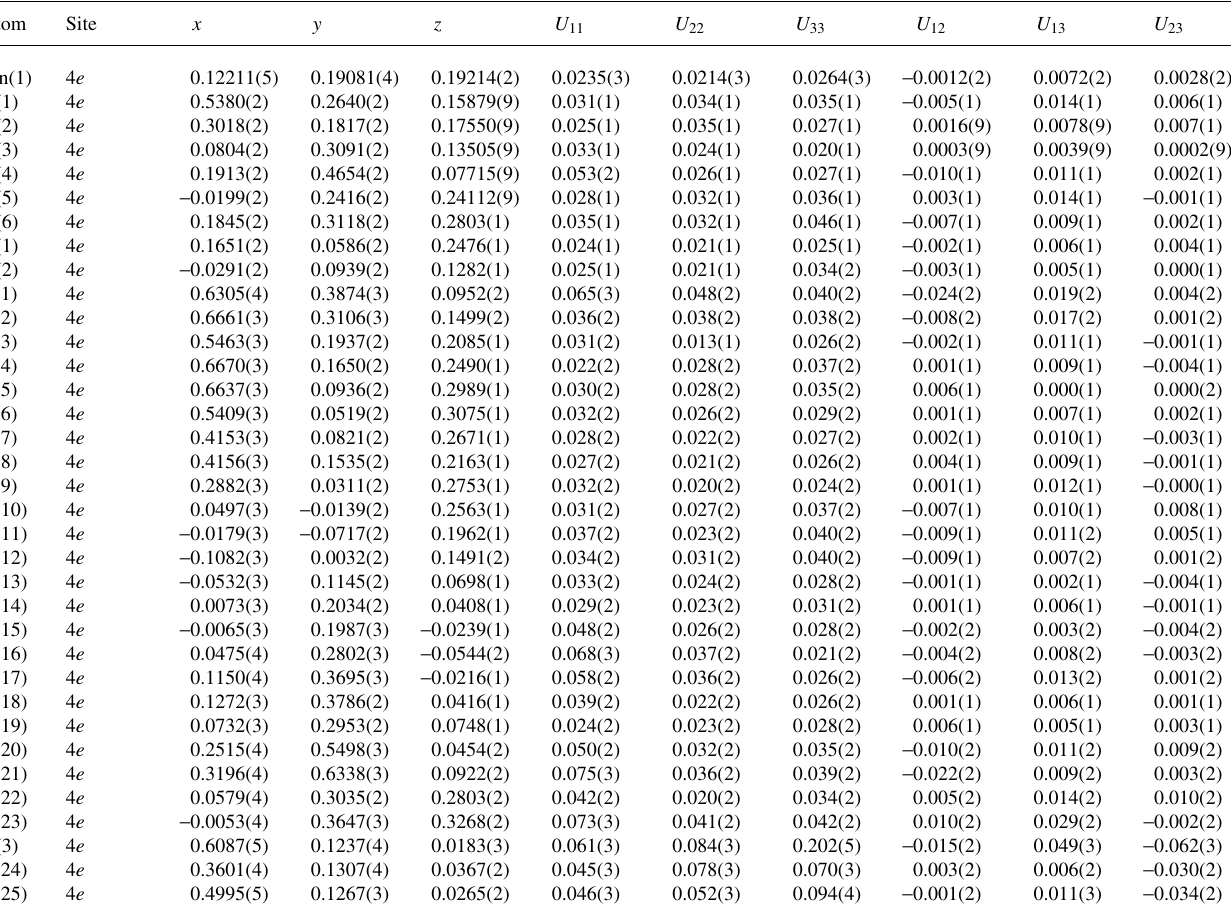
Table 3. Atomic coordinates and displacement parameters (in Å 2 )